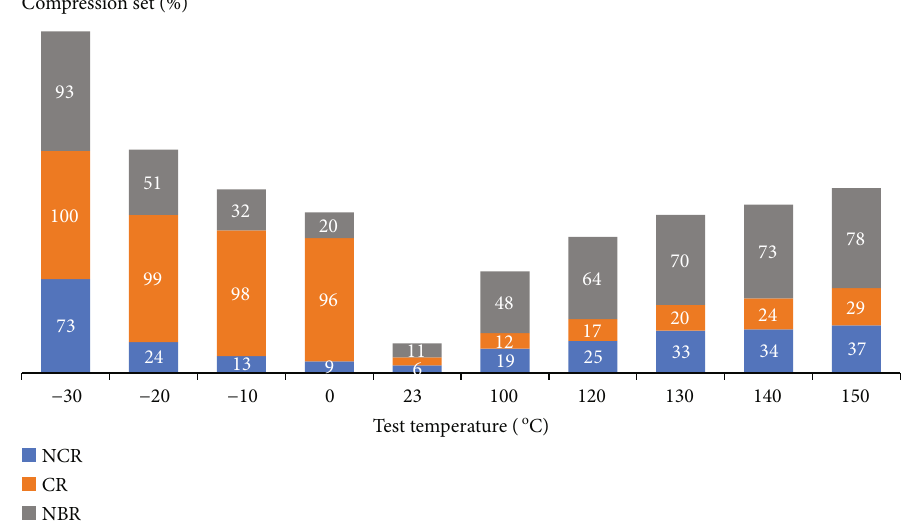
Figure 5: Compression set (%) of vulcanizates of acrylonitrile-chloroprene rubber (NCR), chloroprene rubber (CR), and nitrile rubber (NBR) after 72 hrs at di ff erent test